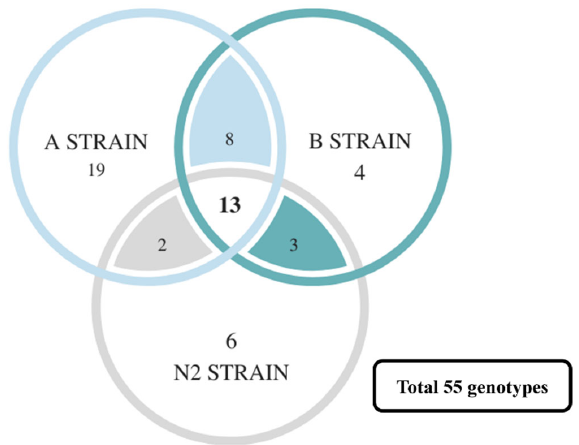
Figure 6. The Venn diagram of disease ‐ resistance ‐ associated genotypes in A, B, and N2 strains. Total number of genotypes is 55. number of genotypes is